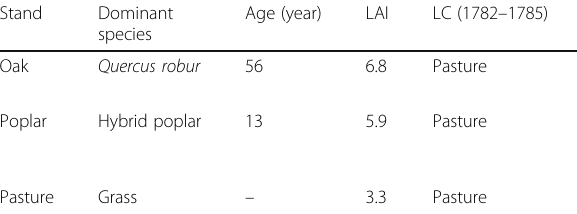
Table 1 History and present state of sample areas